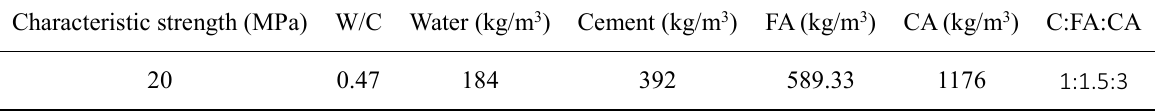
Mix proportion for concrete grade 20.